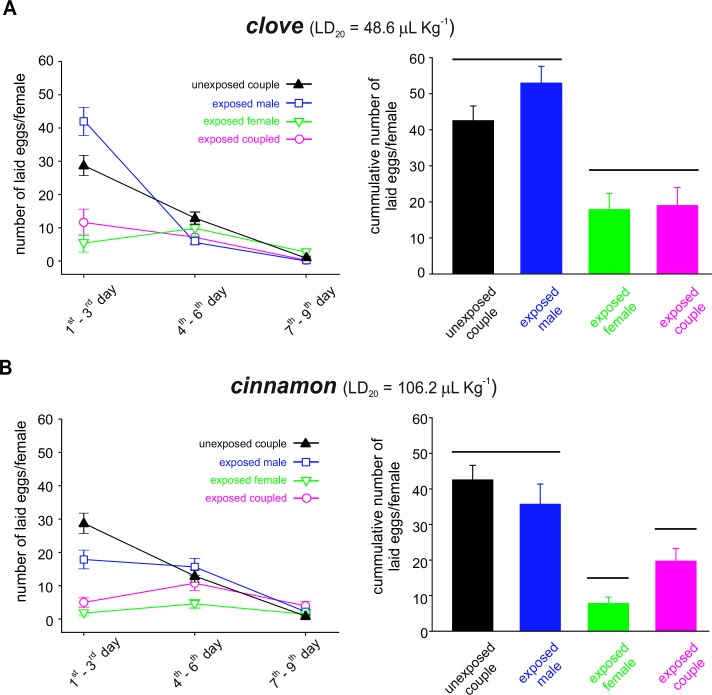
Effects of sublethal exposure to essential oils on C. maculatus oviposition.Number of eggs of C. maculatus females that were sublethally exposed to clove (A) or cinnamon (B) essential oils and coupled with essential oil-treated or essential oil-untreated partners. The symbols represent the means of 20 replicates (± SD) for the number of eggs laid by females of C. maculatus at three-day intervals (left panels) and the cumulative number of eggs (right panels) laid on cowpea bean masses during the first 9 days of adulthood. On the right panels, the treatments grouped by the same horizontal line did not differ according to a Tukey HSD test (P < 0.05).